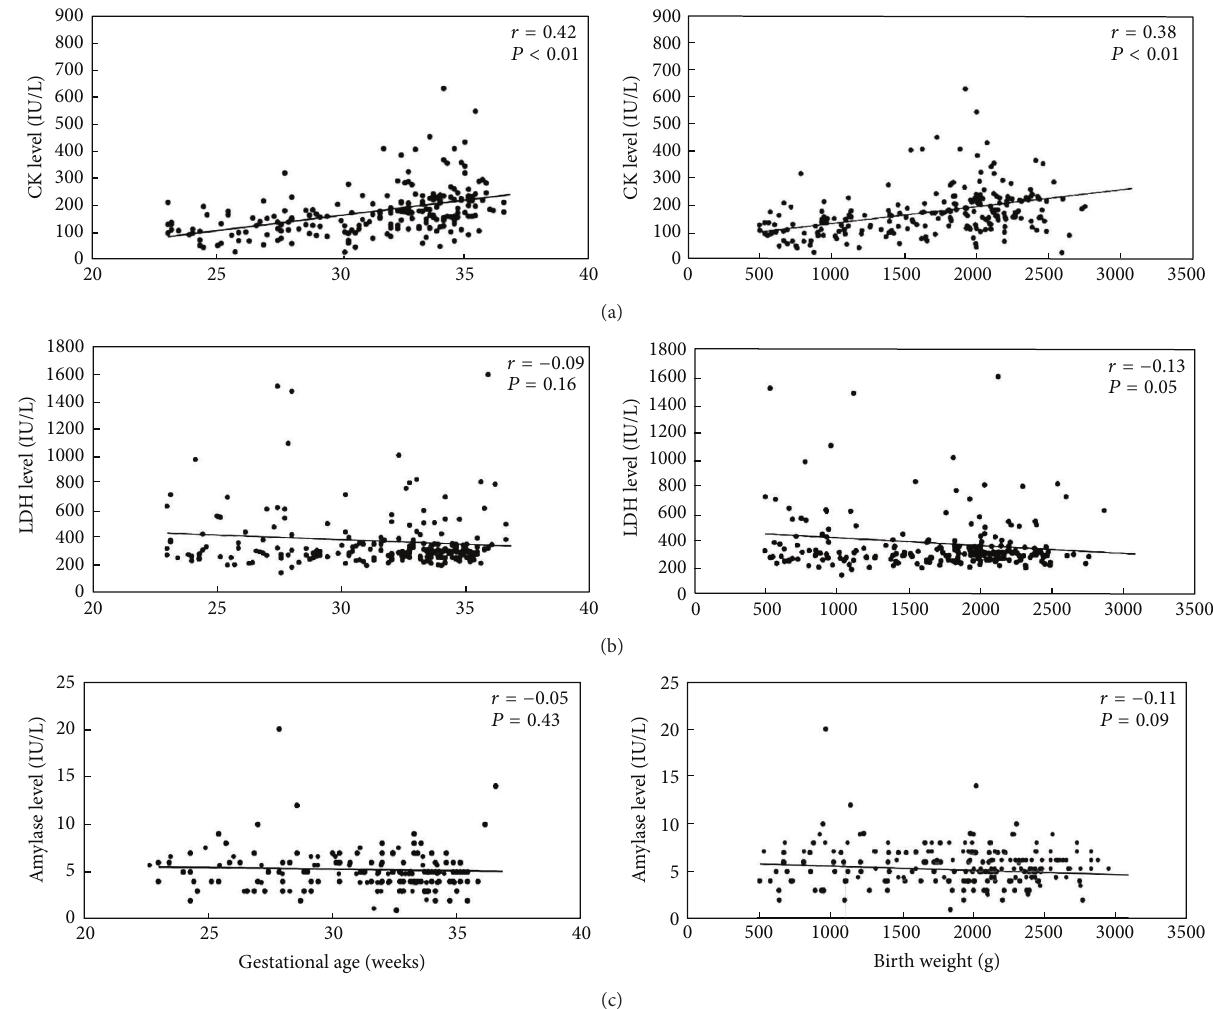
Figure 4: Correlation between CK, LDH and amylase levels and gestational age and birth weight in total patients. might be due to a direct effect of the ritodrine hydrochloride in infants with higher ritodrine concentration in short-term ritodrine tocolysis. However, in long-term ritodrine tocolysis group, no correlation was found between amylase levels and gestational age or birth weight. There was an inverse relation- ship between short-term tocolysis and long-term